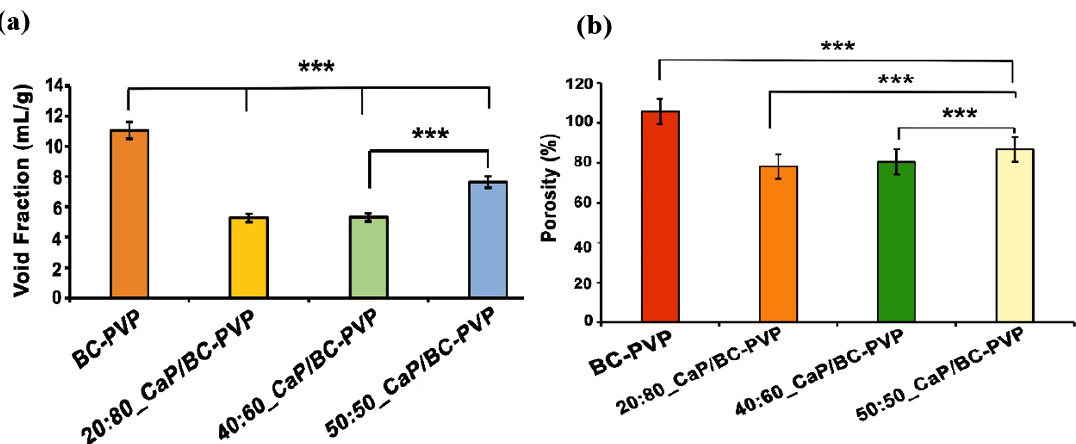
Figure 1. Void fraction ( a ) and Porosity ( b ) of calcium phosphate incorporated BC based